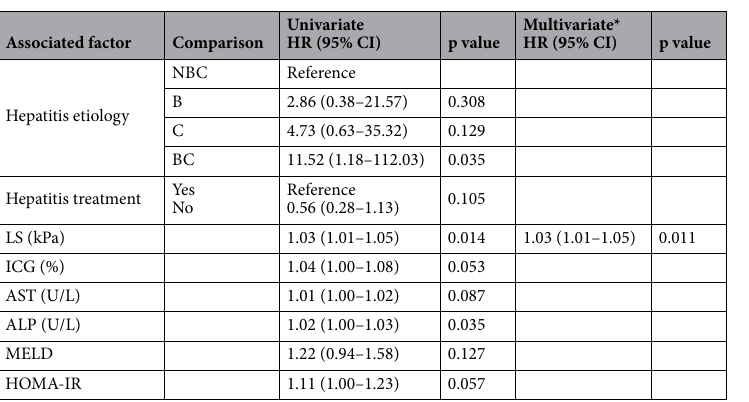
Table 2. Uni- and multi-variate analysis of factors associated with hepatoma recurrence (n = 94). B hepatitis B virus, C hepatitis C virus, NBNC non-hepatitis B virus and non-hepatitis C virus, LS liver stiffness, ICG indocyanine green, AST aspartate aminotransferase, ALP alkaline phosphatase, MELD model for end stage liver disease, HOMA-IR homeostatic model assessment for insulin resistance, *all characteristics in Table 1 were included in the univariable analysis and those with p values < 0.2 was entered into stepwise multivariable